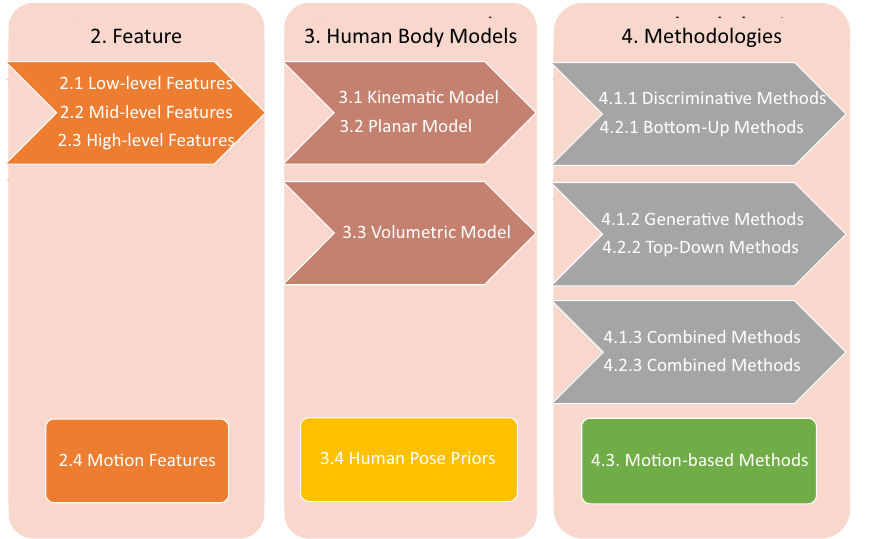
Figure 1. The Composition of The Review. The survey considers three processing units, and dedicates one section to each. After these three processing units, human poses can be estimated from images. Each directed flow chart denotes the composition of specific types of methods. Rectangle units are motion-based